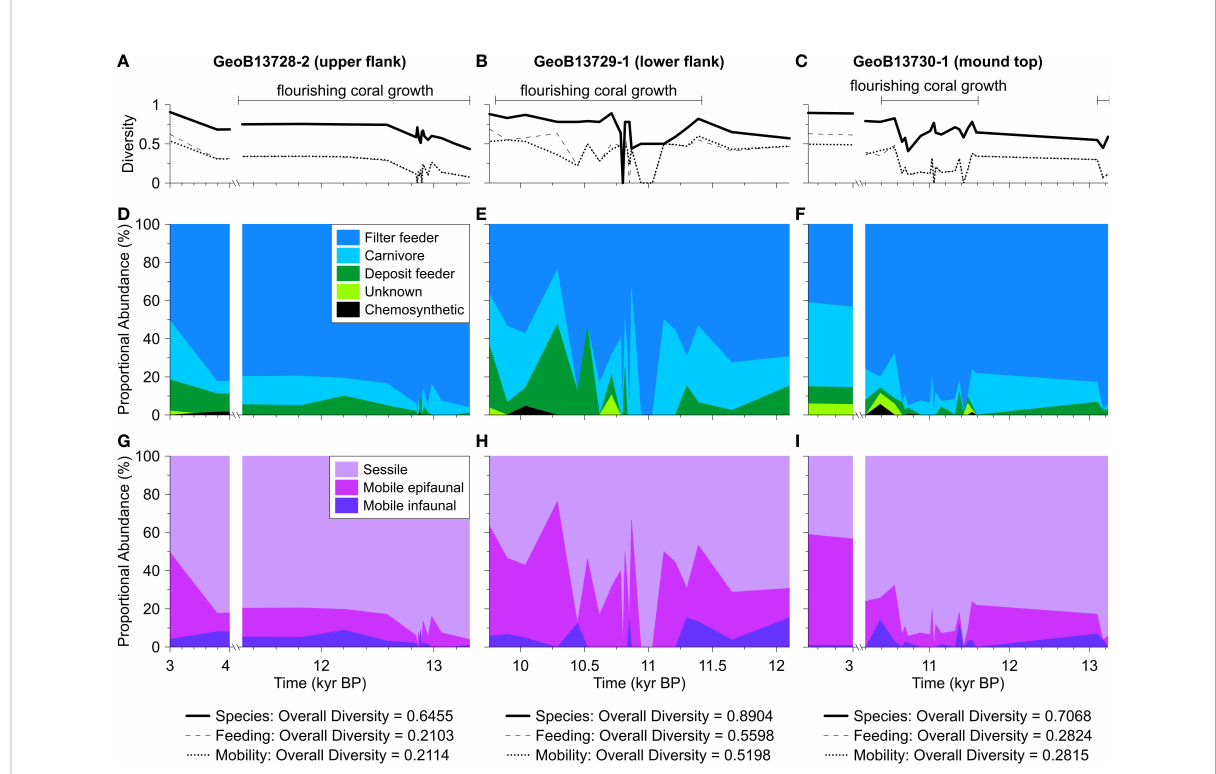
FIGURE 4 Molluscan ecological data for cores GeoB13728-2, GeoB13729-1, and GeoB13730-1. (A-C) Diversity indices for molluscan species, feeding groups, and mobility groups in each assemblage (sample) and for each core overall (see values below plots). Proportional abundances of (D-F) feeding groups and (G-I) mobility groups in each assemblage. The legend for (D-F) is in (D) , and legend for (G-I) is in (G) . Note that the x-axis breaks from 11.3 – 4.0 kyr BP (thousands of years before present) in fi gures (A, D, G) and from 10.2 – 3.0 kyr BP in fi gures (C, F, I) . These axes breaks are based on coral ages and interpolated ages of molluscan